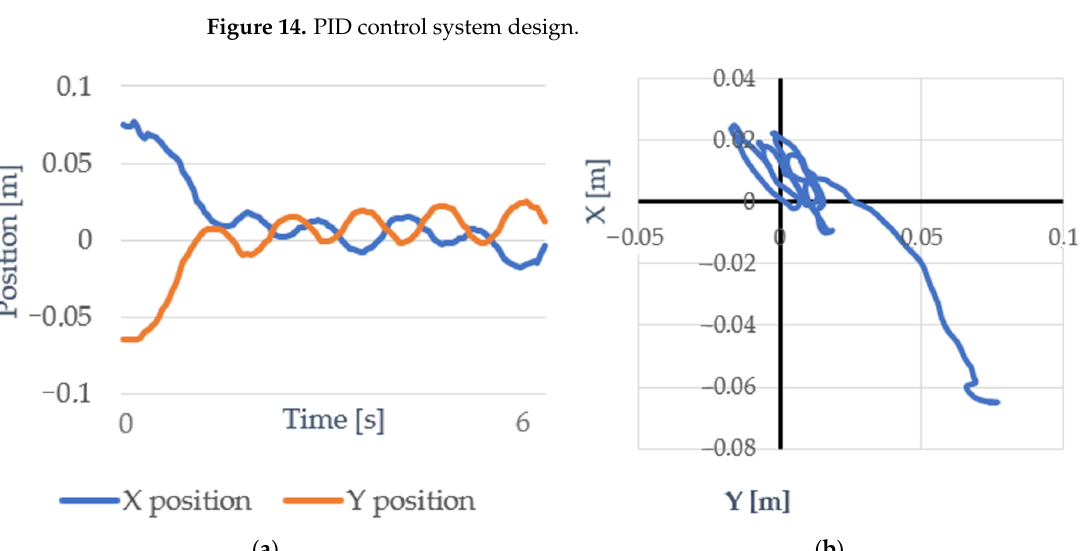
Figure 15. ( a ) Example run: X and Y positions in the real environment using PID control; ( b ) Positions in 2 dimensions.